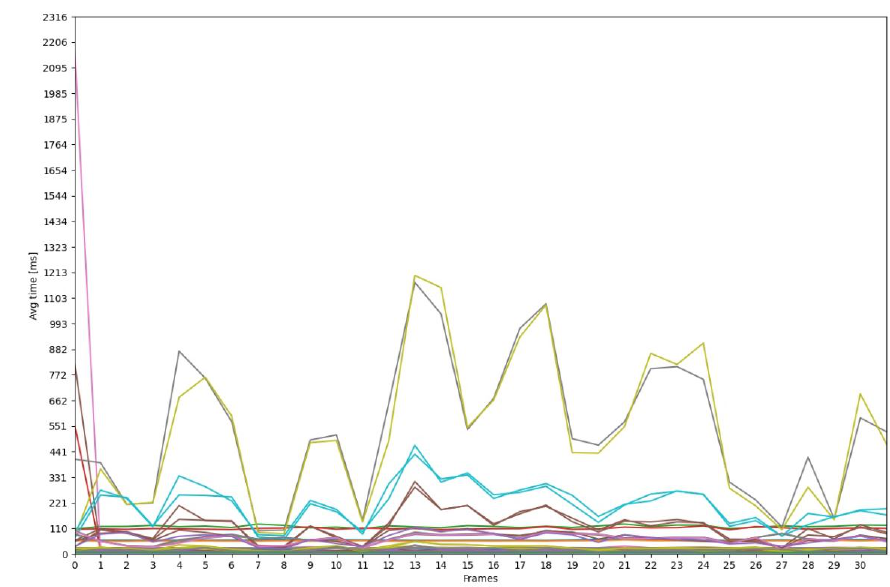
Figure 24. Average runtime of